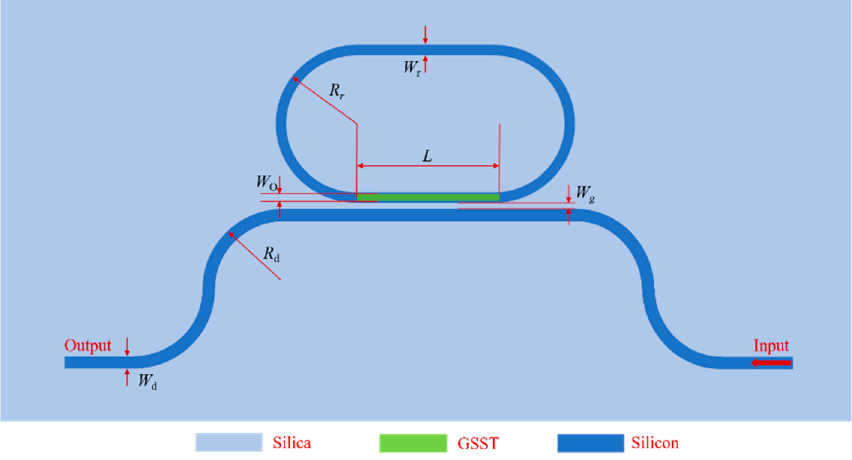
Figure 1. Schematic configuration of the proposed 1 × 1 optical switch based on a GSST-assisted racetrack MRR.